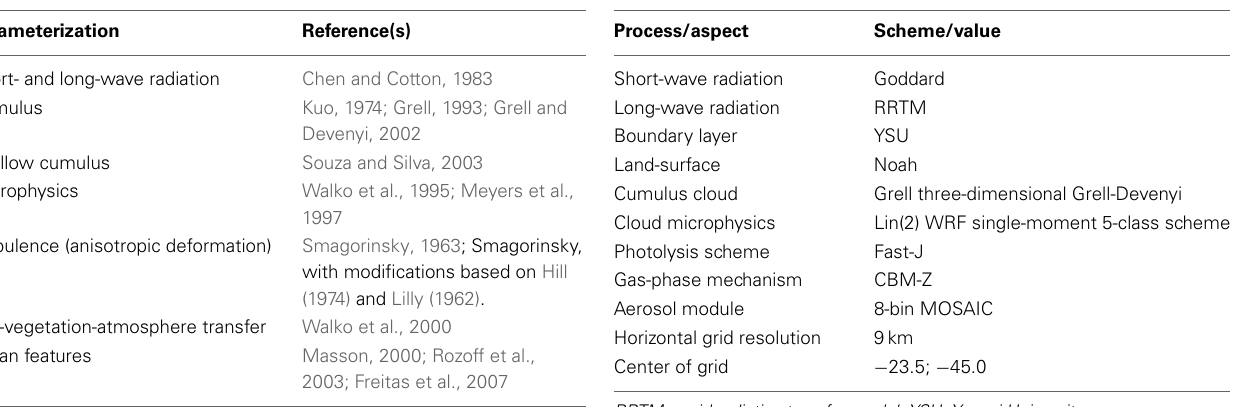
Table 2 | Physical parameterizations used in the BRAMS-SPM. Table 3 | Model configuration options in the WRF/Chem simulations.